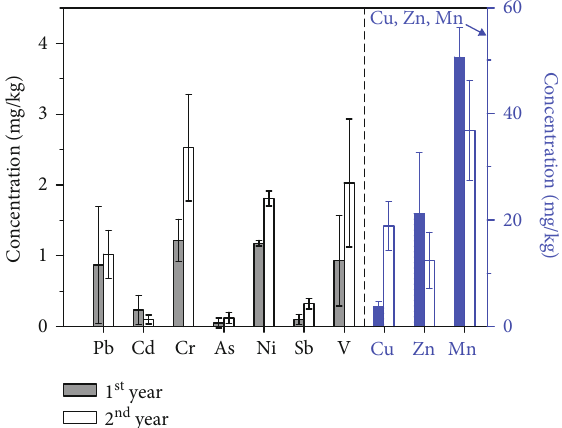
Figure 5: The concentration of heavy metal in fruit of Indigofera amblyantha Craib in two natural years. The 1st and 2nd years were the ninth month and the twenty- fi rst month, in winter. The error bar was the standard